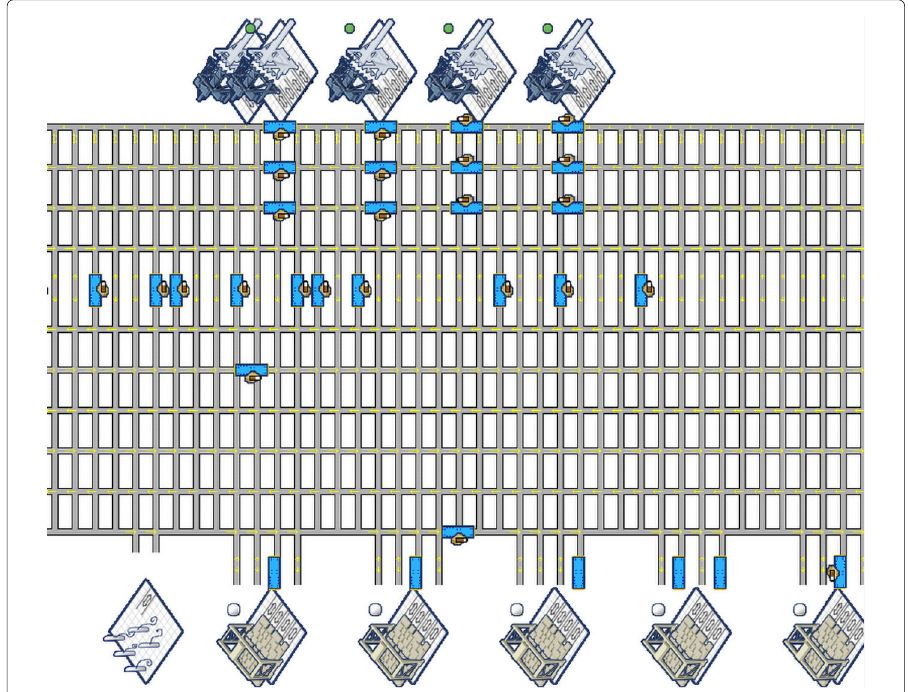
Fig. 8 Segment of the simulated container terminal while onloading a ship: 5 (of 16) gantry cranes (top) with 3 rows of AGVs (blue rectangles) in loading position, the grid of possible driving lanes (middle) with more AGVs queuing (vertically oriented) and in transit (horizontically oriented). Bottom row shows 5 (of over 30) container storage areas. The bottom left symbol indicates a charging stations with 7 ACS